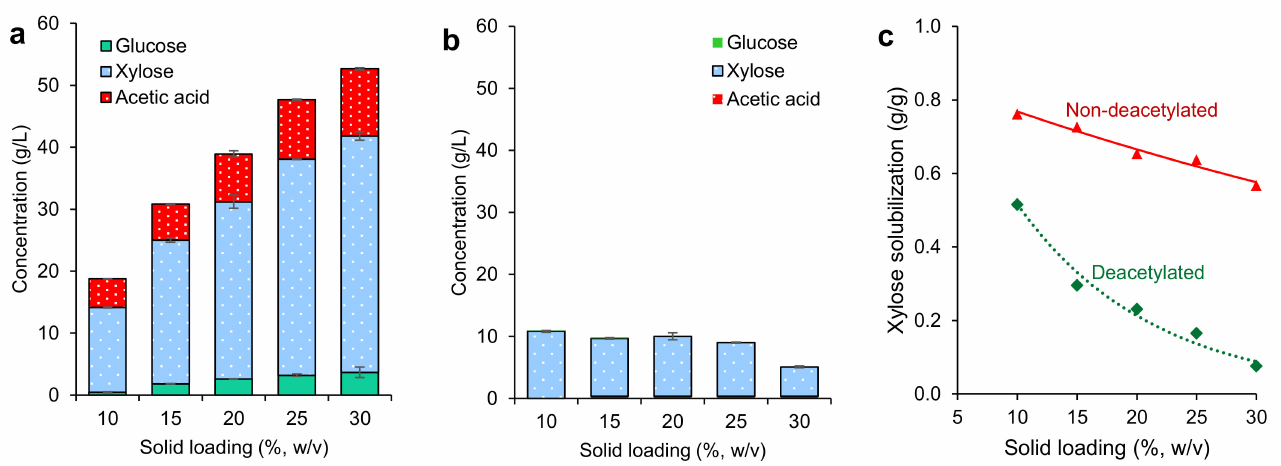
Figure 5. Effect of deacetylation at different solid loadings post-dilute acid pretreatment ( a ) non- deacetylated oil palm trunk (OPT), ( b ) deacetylated OPT, and ( c ) xylose solubilization of non- deacetylated and deacetylated